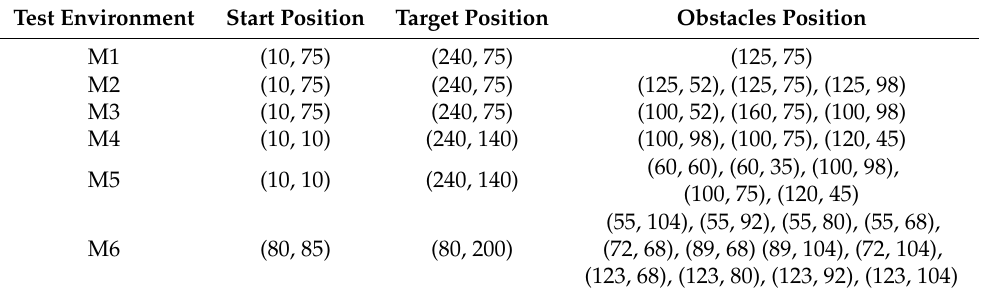
Table 1. Test environment of the simulations.